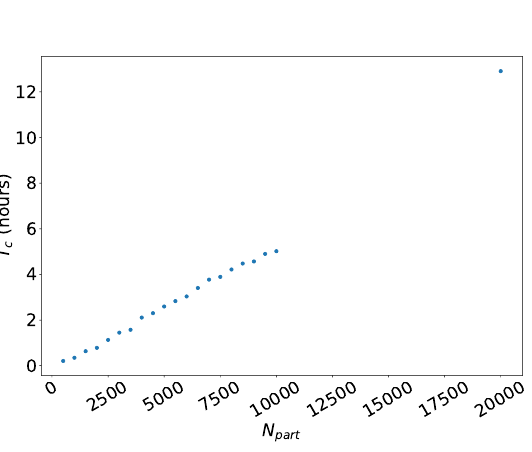
Figure 3. RMS error on q and (cid:15) V for all S1 simulations